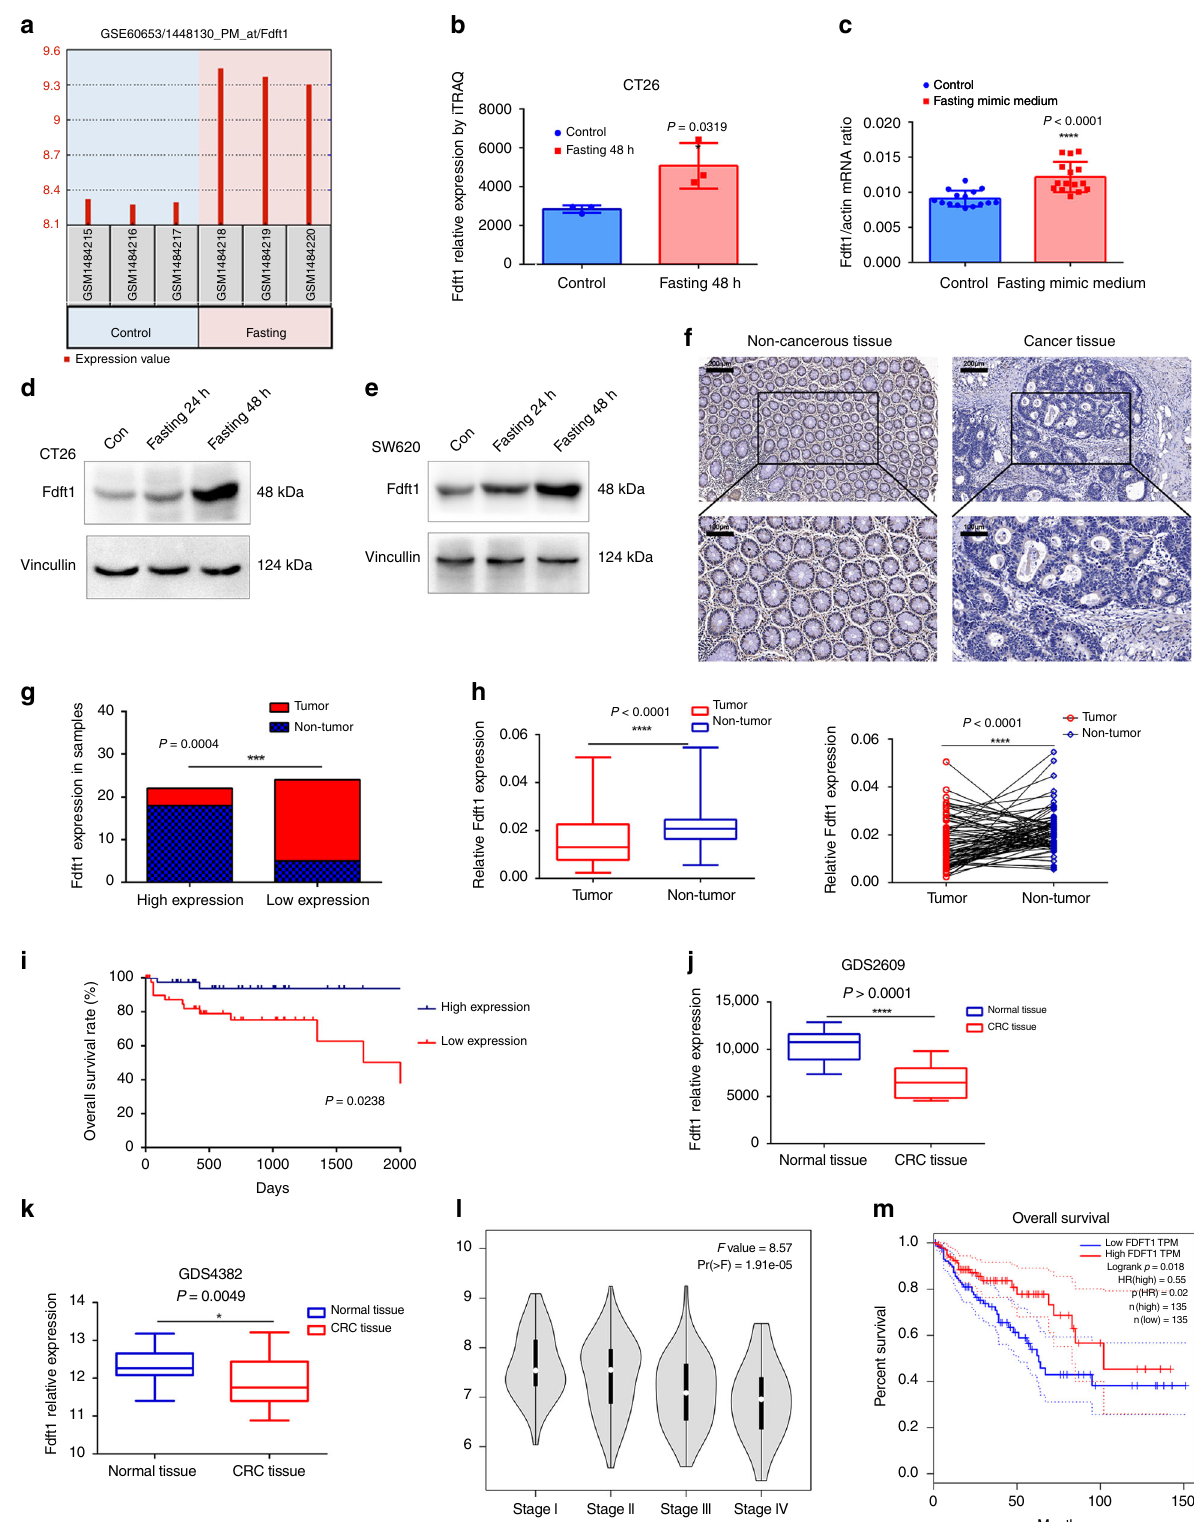
colony-forming capacity of CRC cells (Fig. 3k, l; Supplementary Fig. 15e, f), whereas FDFT1 knockdown enhanced it (Fig. 3m, n; Supplementary Fig. 16e, h). To further investigate the effect of FDFT1 on cell invasion, a Transwell assay was performed. FDFT1 overexpression inhibited cell invasion (Fig. 3o, p), whereas FDFT1 knockdown increased it (Fig. 3q, r). In addition,